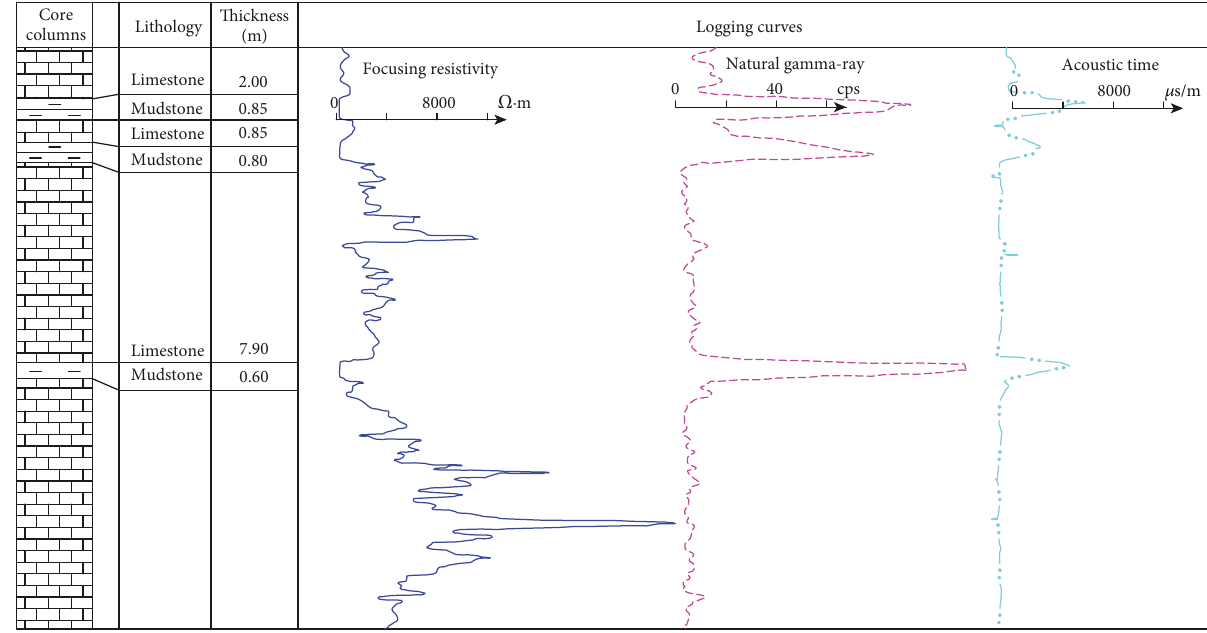
Figure 5: Column of O2-6 hole on the top of Ordovician limestone in the study